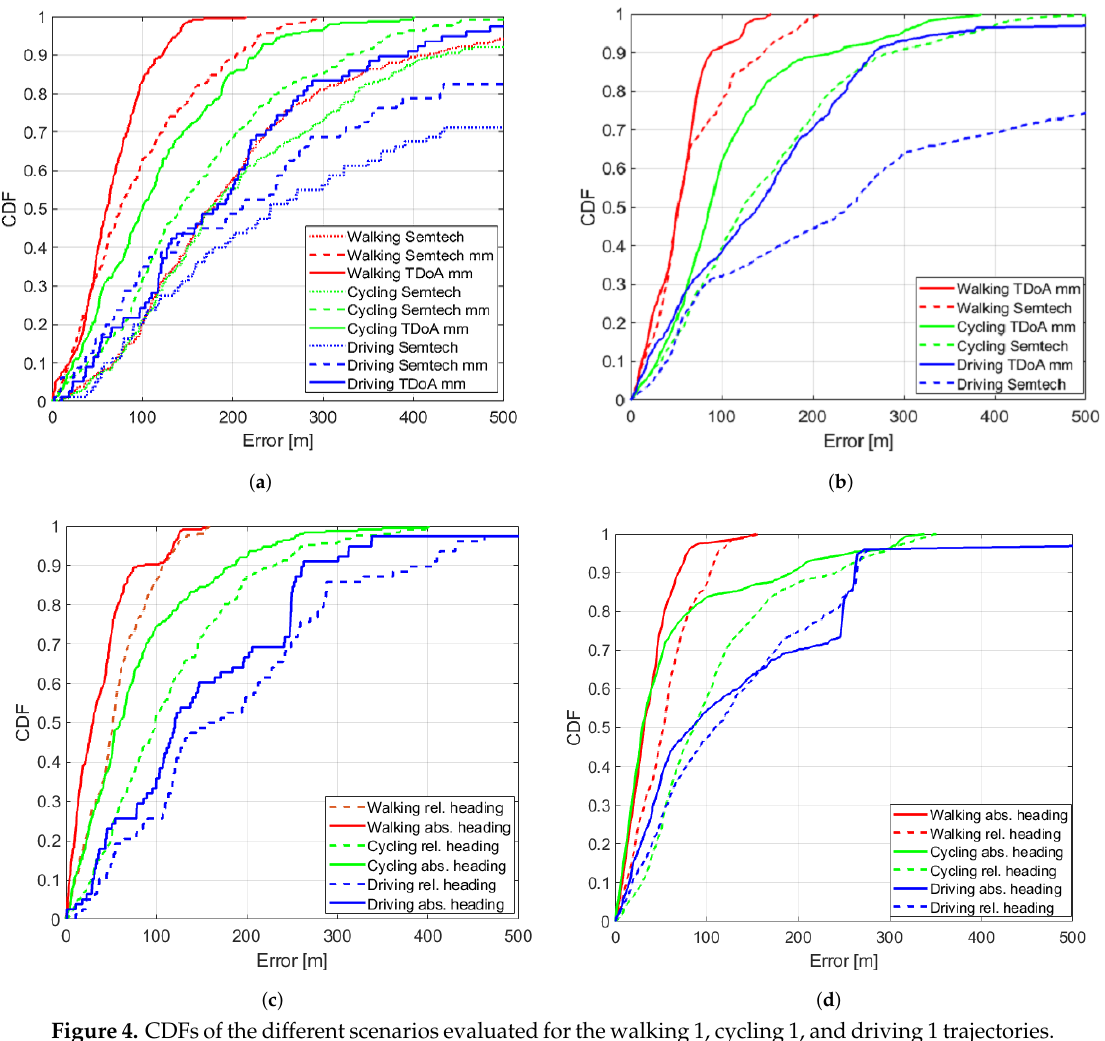
Figure 4. CDFs of the different scenarios evaluated for the walking 1, cycling 1, and driving 1 trajectories.